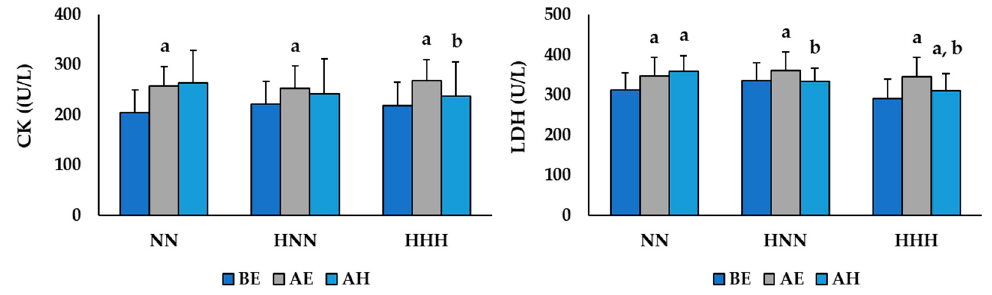
Figure 4. Changes muscle damage markers according to HBOT after exercise in NN and HH environments. Values are mean ± standard deviation; NN: exercised in normobaric, normoxic conditions; HNN: HBOT treatment after exercising in normobaric, normoxic conditions; HHH: HBOT treatment after exercising in in hypobaric, hypoxic conditions; BE: before exercise; AE: after exercise; AH: after HBOT; CK: creatine kinase; LDH: lactate dehydrogenase; a Significant difference with BE ( p < 0.05); b Significant difference with AE ( p < 0.05).